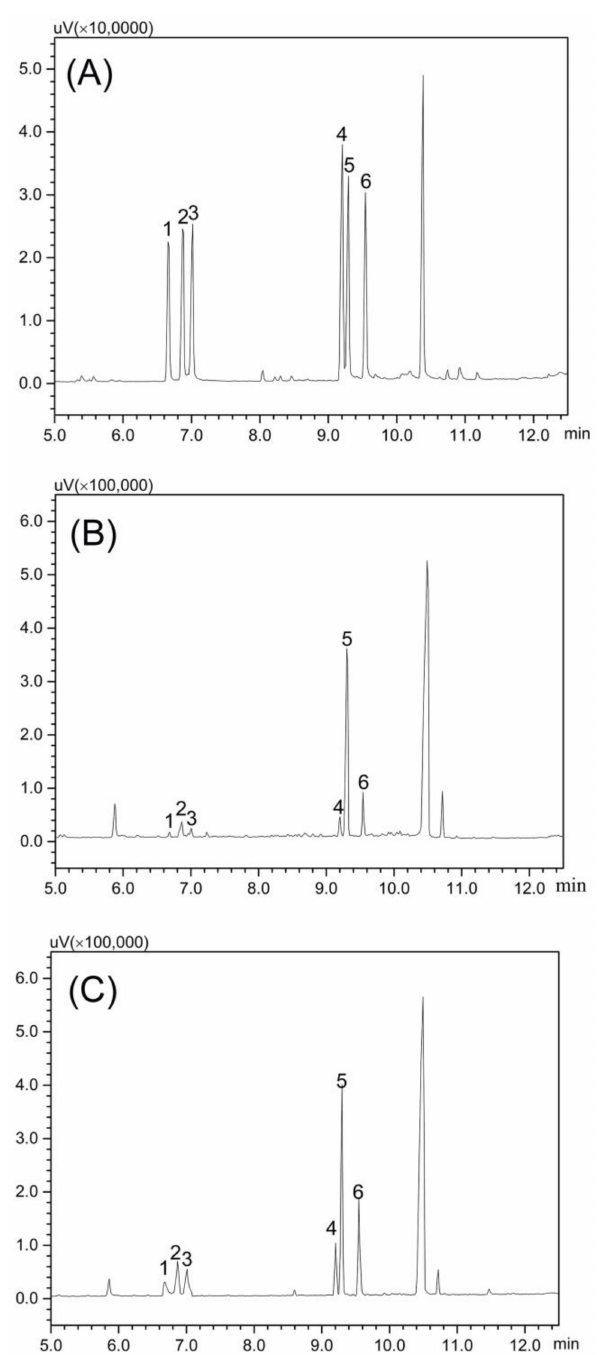
Figure 1. gas chromatography (GC) spectra of standard monosaccharides ( A ), CMPs-4 ( B ), and CMPs-80 ( C ). Peak identity: Rhamnose (1), Arabinose (2), Xylose (3), Mannose (4), Glucose (5), and Galactose